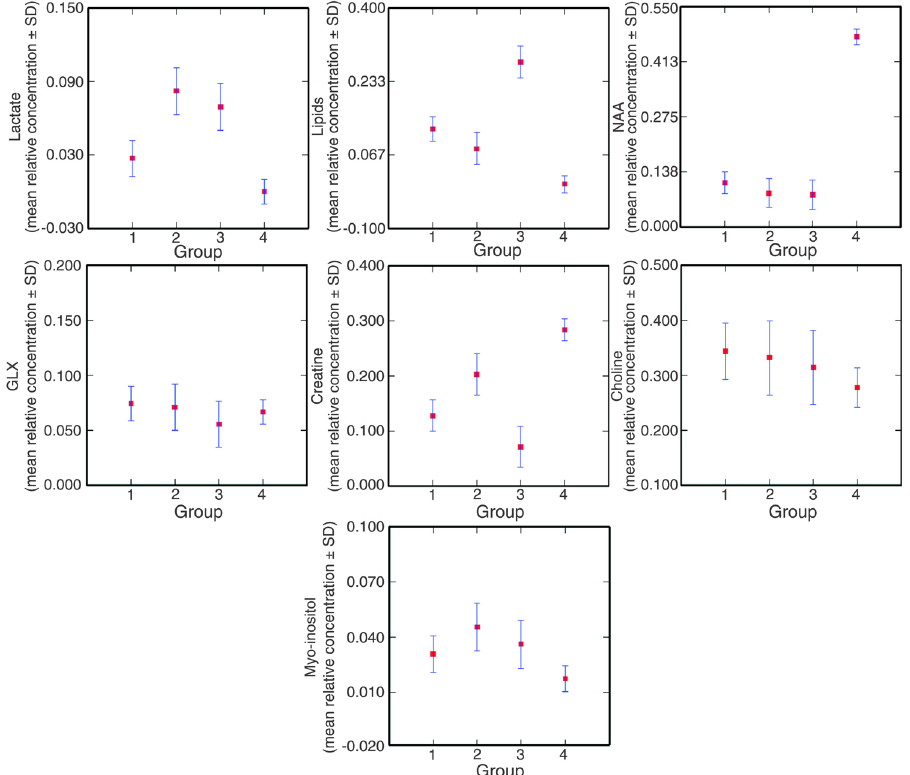
Figure 3. Mean relative concentration ± SD for each tumor group (1 = high-grade neuroglial, 2 = non- neuroglial, and 3 = pilocytic astrocytoma) and for the control group (4). NAA = N-acetyl-aspartate; Glx = glutamate/glutamine